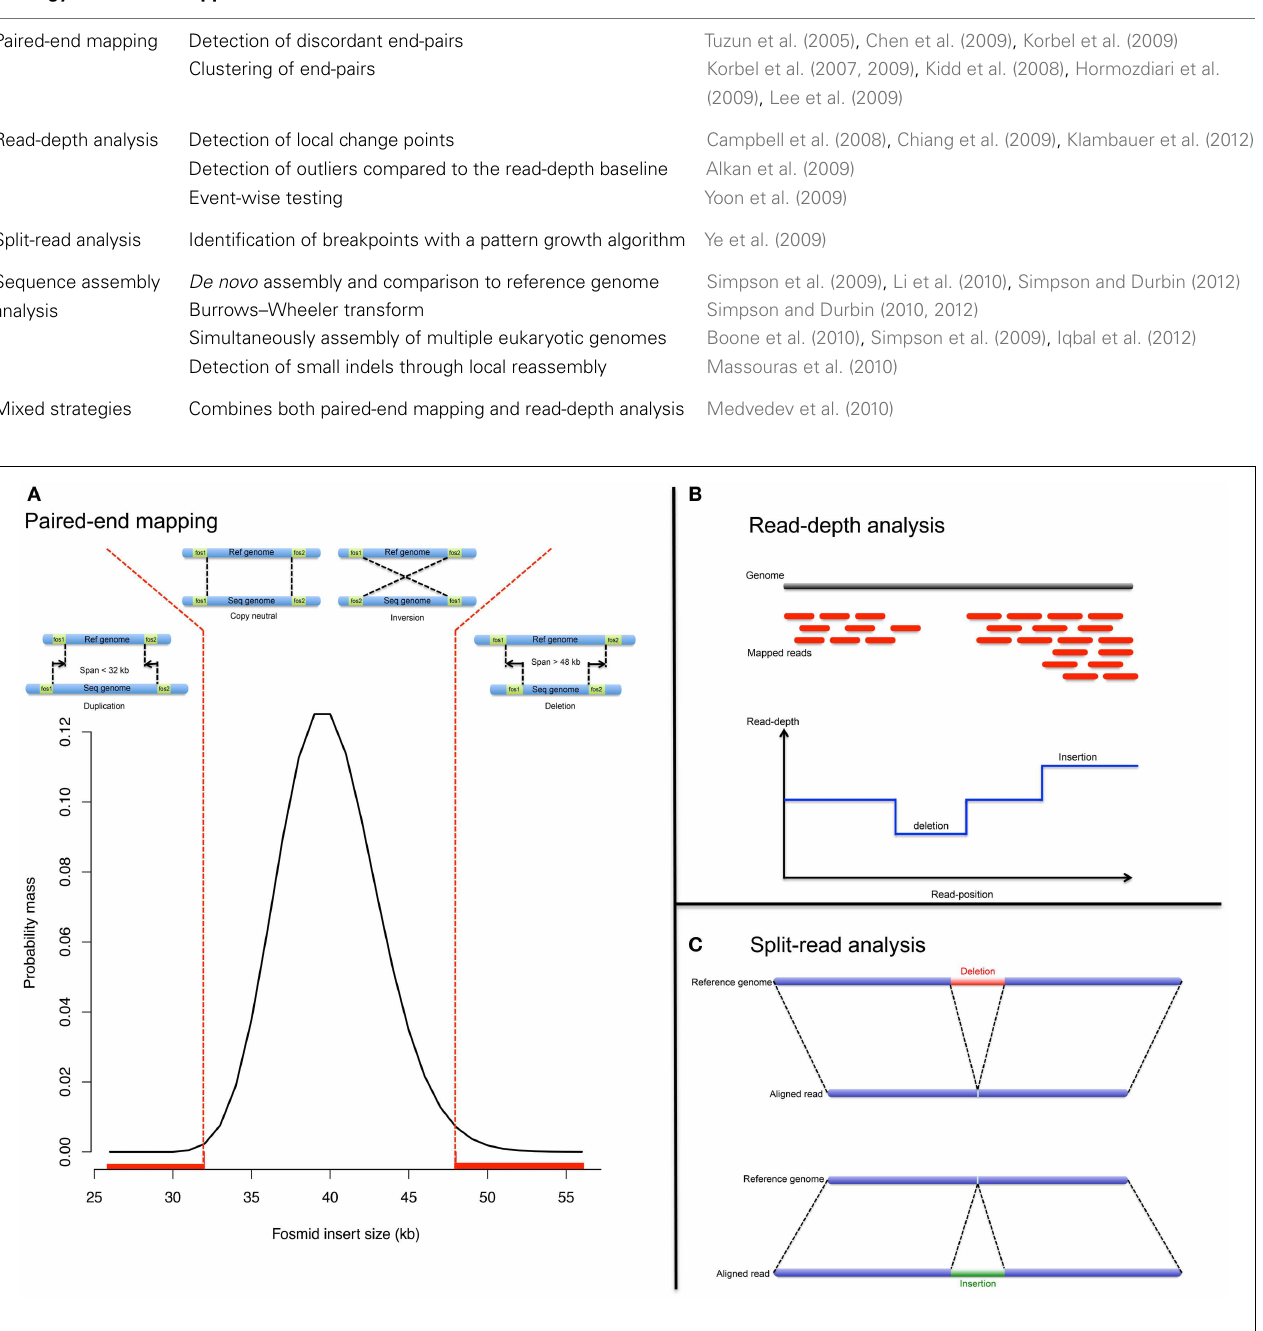
within repeats. Also the detection resolution is limited to the distance between pairs; therefore, neither large nor very small rearrangements can be detected, with the exception of large